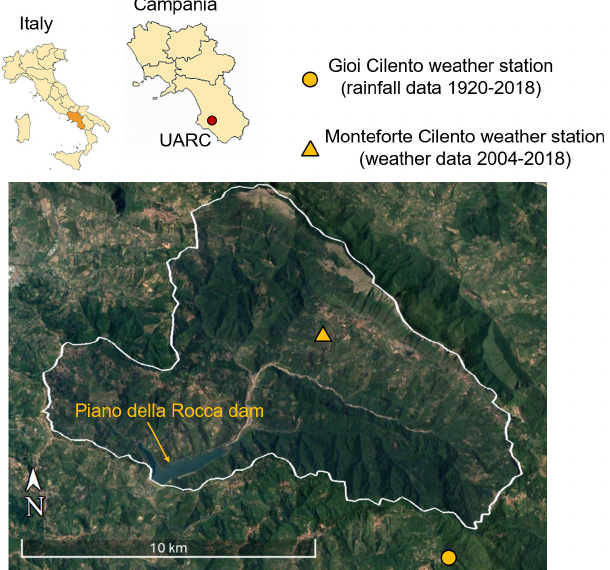
Figure 1. Geographical position of the upper Alento River catch- ment (UARC) in Campania (southern Italy) with the locations of the weather stations of Gioi Cilento and Monteforte Cilento. This figure was adapted from © Google Maps.